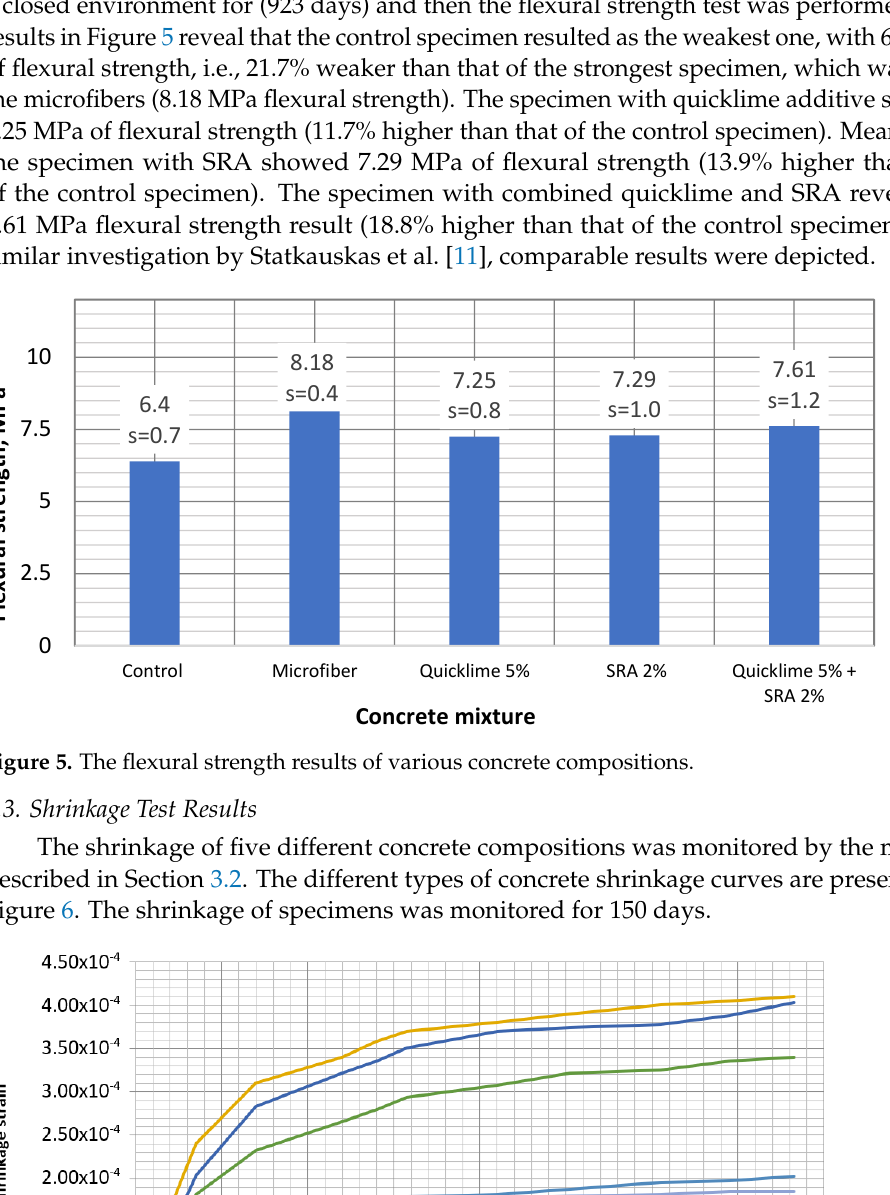
Figure 4. The compressive strength results of various concrete compositions.